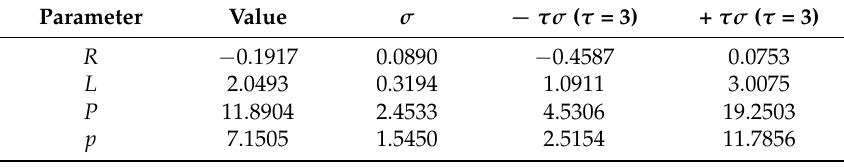
Table 5. Results from the analysis of the vertical displacement of point Ša7.